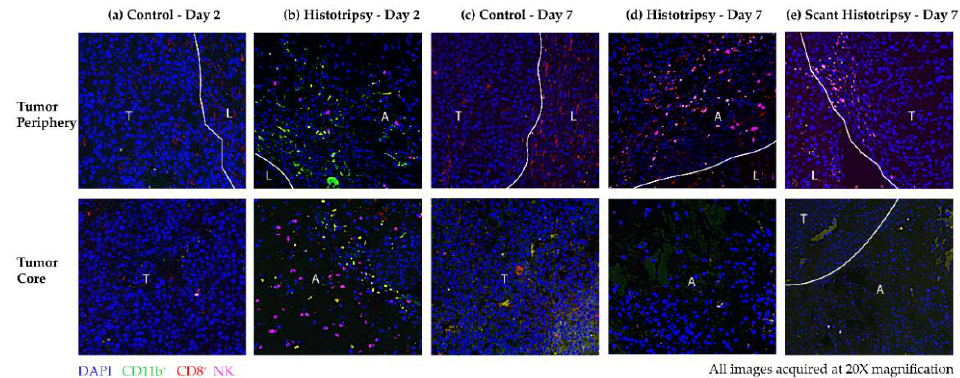
Figure 6. Representative multiplex immunohistochemistry images obtained at 20 × magnification showing immune cell infiltration in ( a ) untreated control (Day 2), ( b ) histotripsy-treated tumor (Day 2), ( c ) untreated control (Day 7), ( d ) histotripsy-treated tumor (Day 7) and ( e ) scant histotripsy-treated (<25% tumor volume ablated) tumor (Day 7) at the tumor periphery (top) and tumor core (bottom). All days are measured from the histotripsy-treatment timepoint. (L: Liver, A: Ablation Zone, T: Tumor). The samples were stained for DAPI (blue), CD11b (green), CD8 (red) and NK (pink). ( a ) Control — Day 2: There is minimal immune infiltration at the core of the untreated control tumor. ( b ) Histotripsy — Day 2: At the periphery, increased infiltration of CD11b + and NK cells is observed, NK cells are also observed at the core of the ablation zone. ( c ) Control — Day 7: There is some infiltration of CD8 + cells at the periphery, but no substantial infiltration is observed at the tumor core. ( d ) Histotripsy — Day 7: NK and CD8 + cells infiltrated the tumor periphery and were also detected at the core of the ablation zone. ( e ) Scant Histotripsy — Day 7: Some CD8 + and NK cells are observed at the untargeted tumor – liver interface, but no substantial infiltration is observed in the ablation zone.